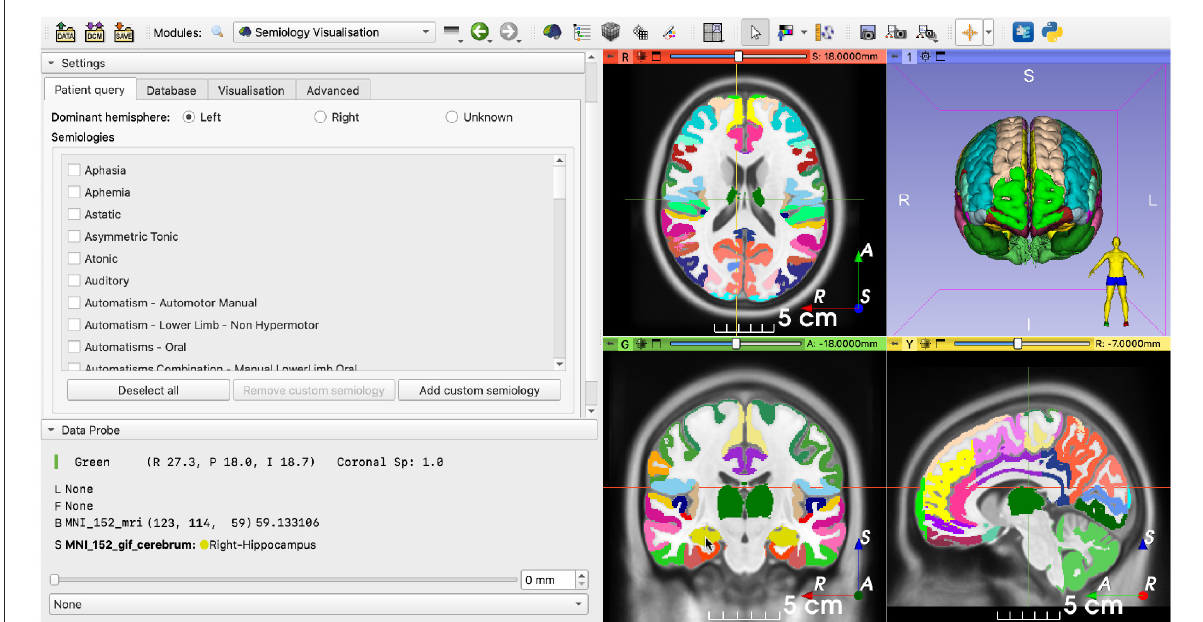
FIGURE2 Semiology visualization module after loading an MNI template as image reference and its corresponding brain parcellation. (Left) Main panel containing a list of suggested semiology terms to be selected by the user; (Right) Images in the patient’s space. Images are shown using the radiological convention, i.e., the left hemisphere is shown on the right and vice versa.